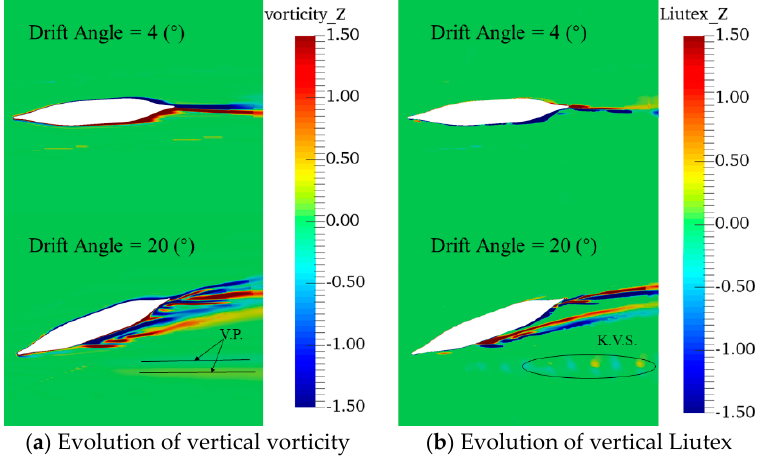
Figure 10. Evolution of the vertical vorticity ( a ) and Liutex ( b ) at z / L pp = − 0.03572 along the ship length direction in static drift tests (top: CASE DA4; bottom: CASE DA20).